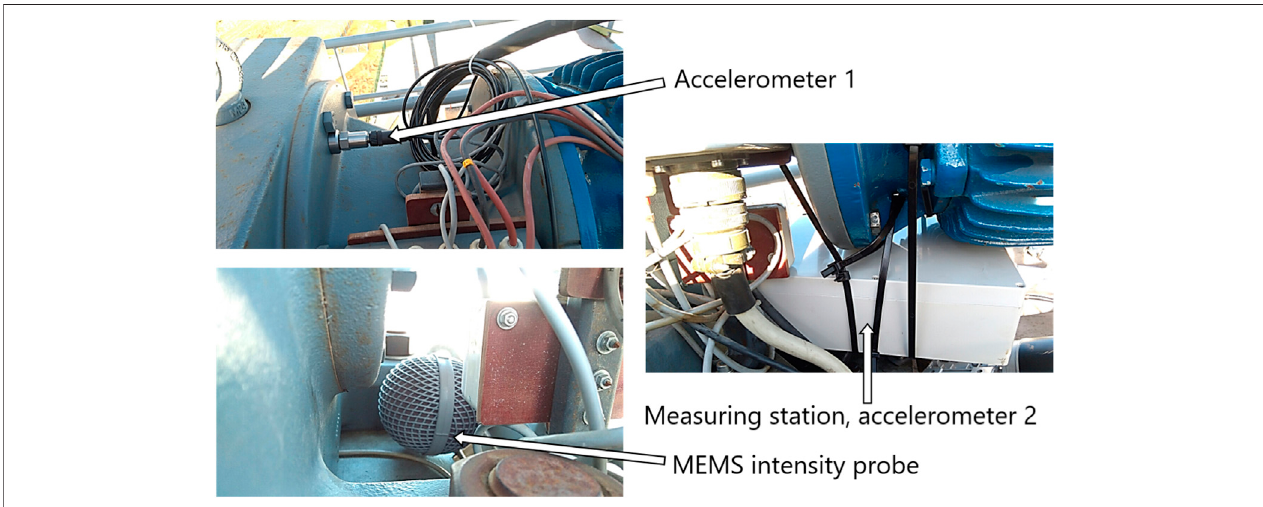
FIGURE 9 | Sensors of the prototype recorder placed in the wind turbine (MEMS intensity probe means acoustic intensity sensor manufactured in micro-electro- mechanical, i.e., MEMS technology).